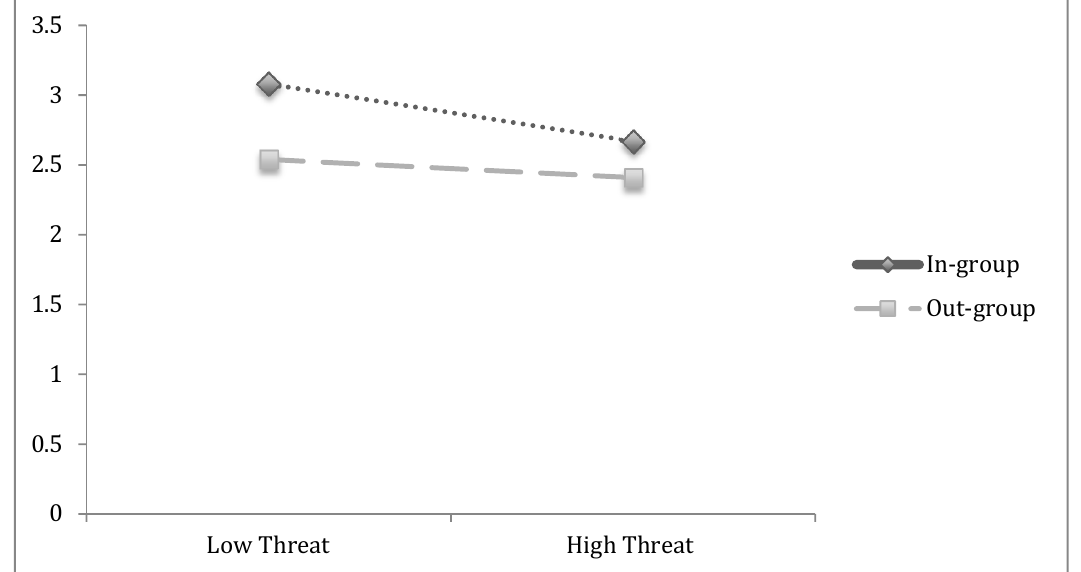
Figure 1. The effect of group membership on forgiveness moderated by the threat to the stereotype.